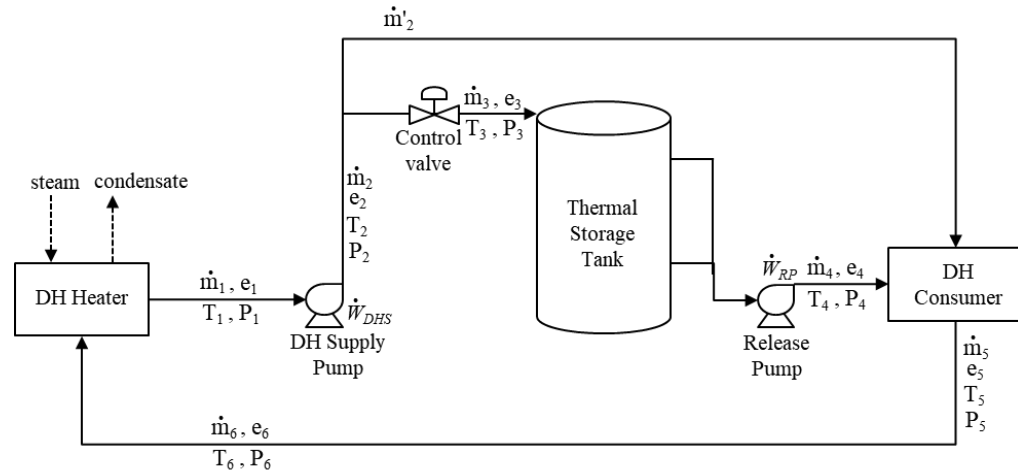
Figure 2. Schematic diagram of thermal energy system (TES) in district heating system.